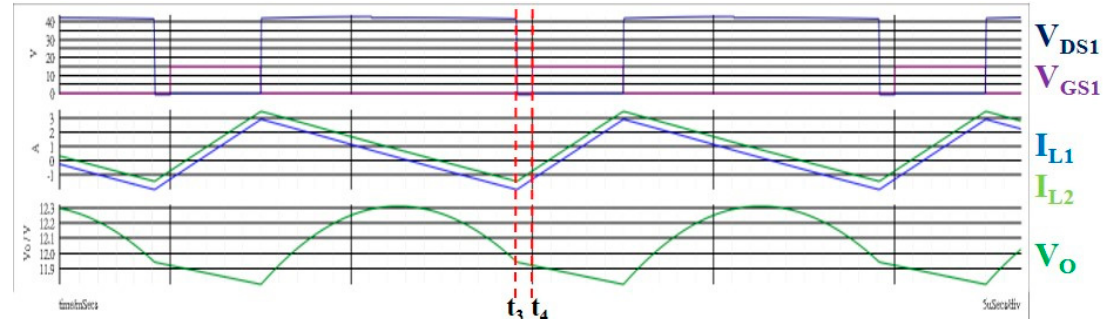
Energies 2020 , 13 , x FOR PEER REVIEW 9 of 13 Figure 14. V GS 1 , V DS 1 , I L 1 , I L 2 , V 0 of input 18 V. Figure 14. V GS 1 , V DS 1 , I L 1 , I L 2 , V 0 of input 18 V. Figure 14. V GS 1 , V DS 1 , I L 1 , I L 2 , V 0 of input 18 V.